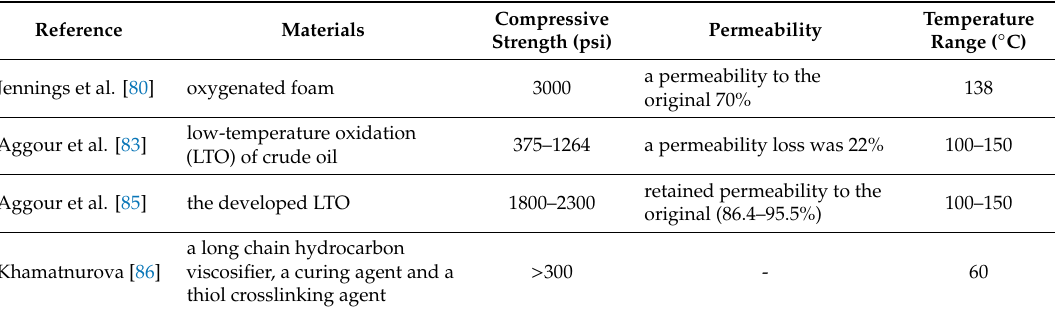
Table 11. Oxidation and hydrocarbon methods to consolidate sand formation.